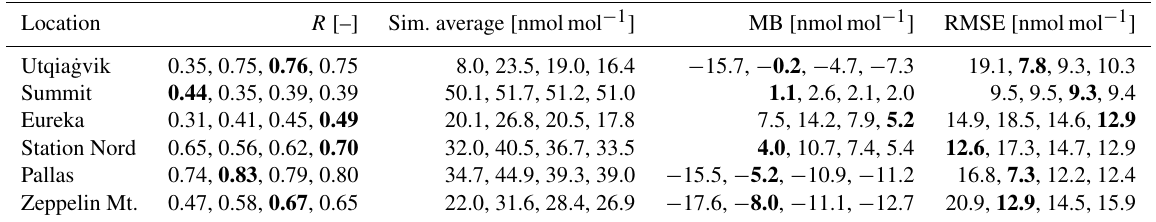
Table 4. Statistics for the ozone mixing ratio at different locations from 1 April to 1 May 2019. The four values in each entry are for the four simulations in this order: infinite FY ice bromide, low bromide, medium bromide, high bromide. The best value is marked in